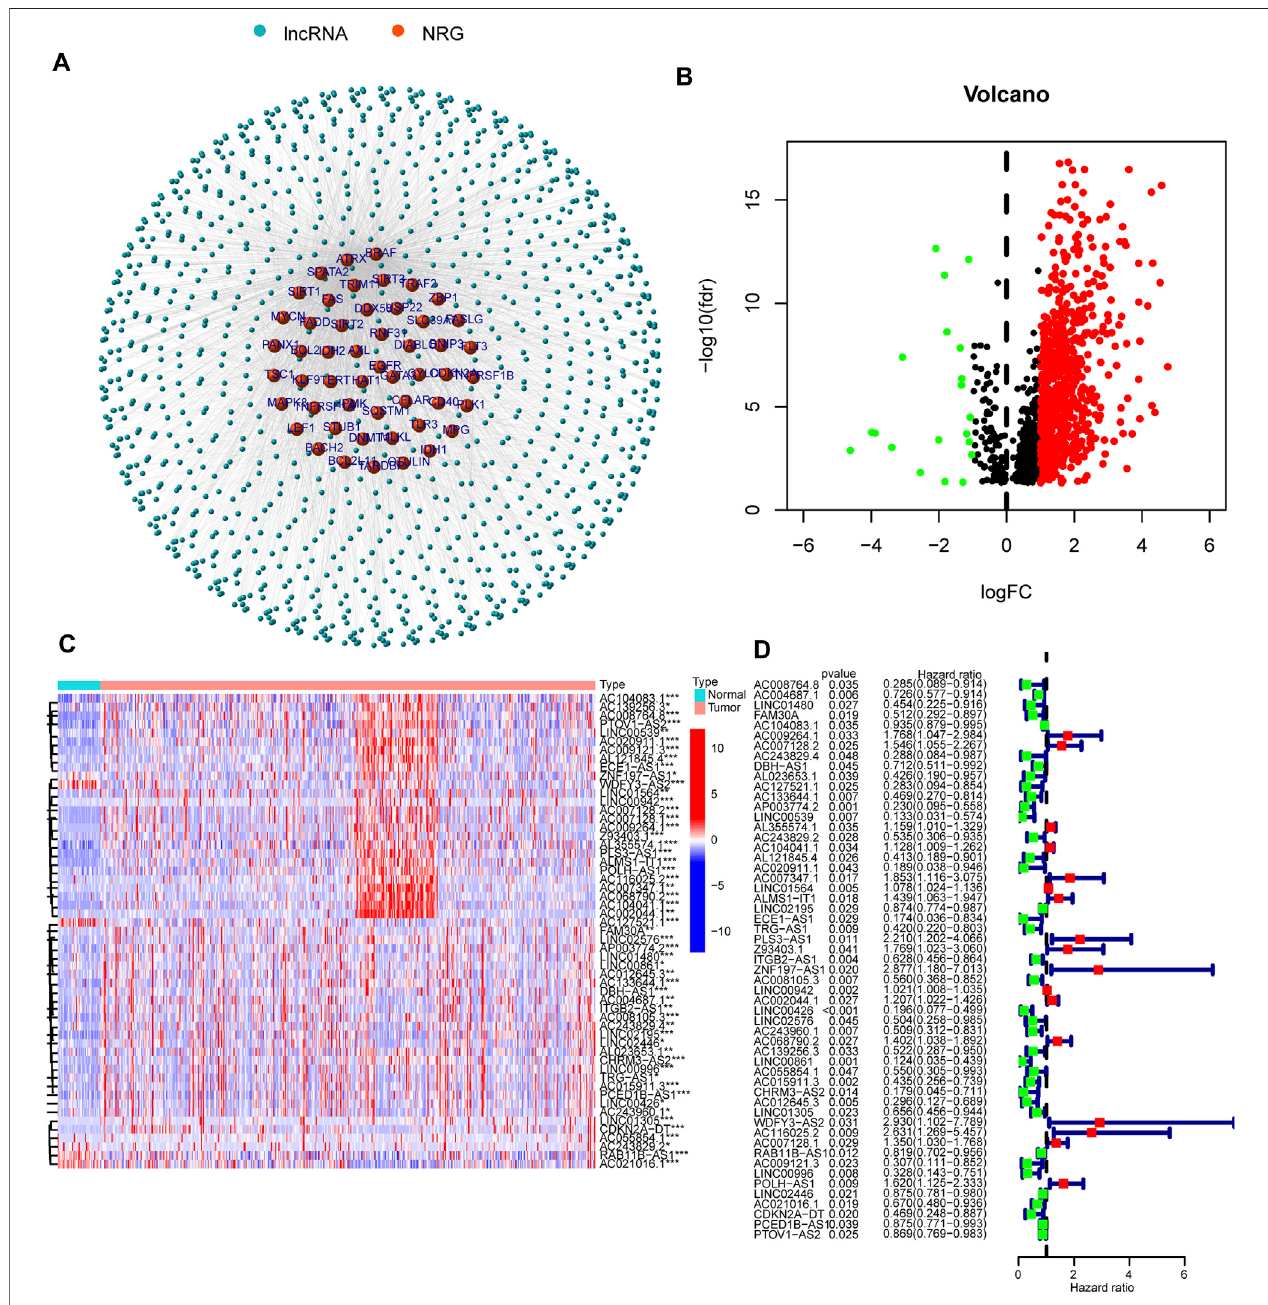
FIGURE 2 | Necroptosis-related lncRNA prognostic signature identi fi ed in HNSCC. (A) Correlation network of necroptosis-related genes and necroptosis-related lncRNAs. (B) Thevolcanoplotof717lncRNAs.ReddotsrepresentedupregulatedlncRNAsandblackdotsrepresenteddown-regulatedlncRNAs. (C,D) Theexpression and univariate Cox regression of 55 prognostic lncRNAs. * p < 0.05; ** p < 0.01; *** p < 0.001.